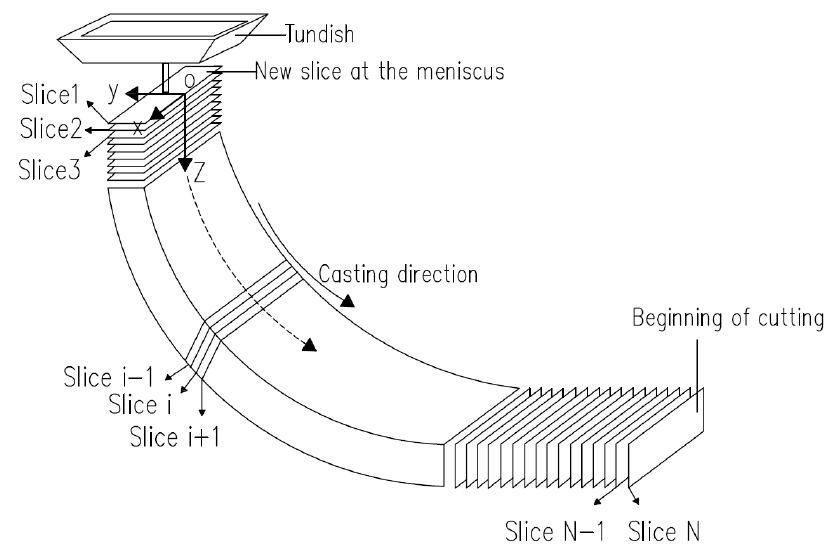
Figure 1. Schematic of space-time dispersion of the internal crack generation index of the slice unit in the slab casting process.